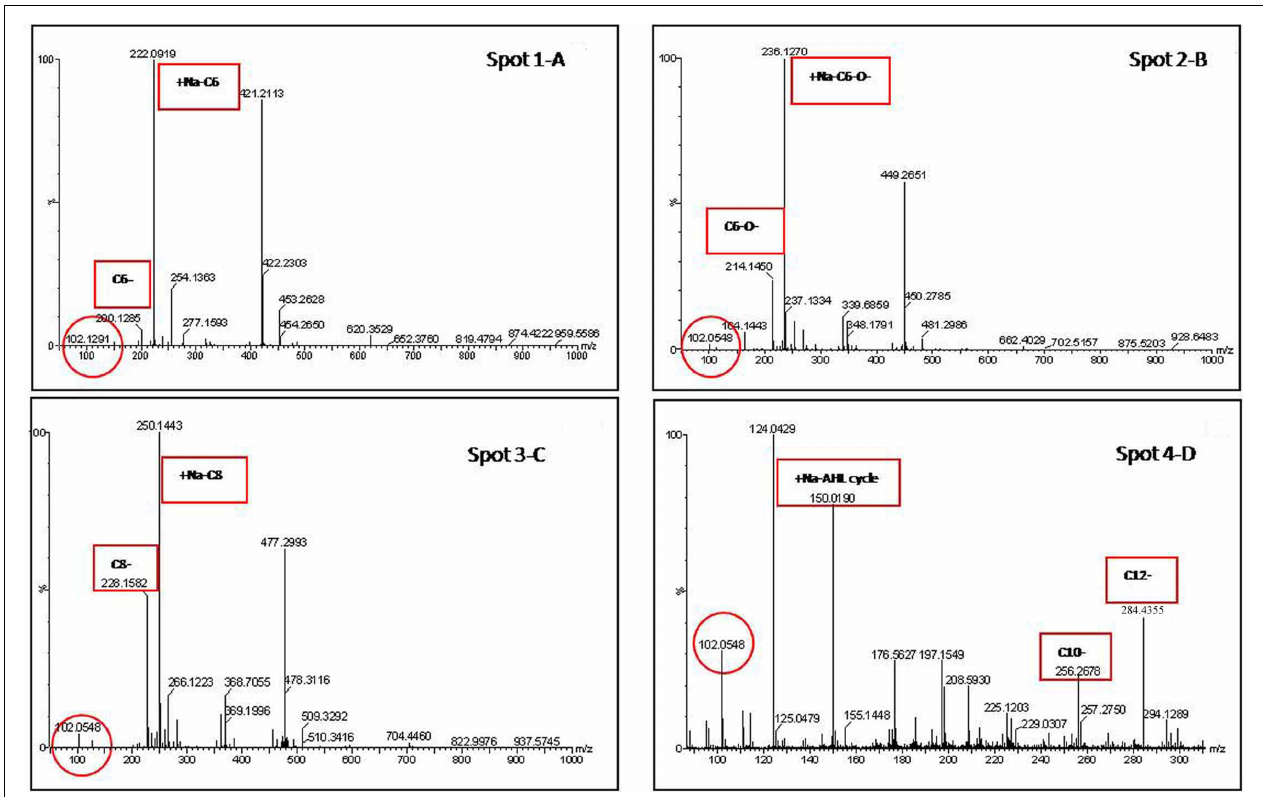
FIGURE 4 | Extracted ion chromatogram of the m/z 102 fragment (a characteristic of the homoserine lactone ring) of AHLs produced by representative strain (OTU2) recovered from preparative TLC. Identification of the AHL in the extract was determined from the mass spectrometry (MS) spectra by comparison with the corresponding AHL standards. For example, the MS data for the spot 1 (A) extract indicates the presence of a characteristic lactone fragment at m/z of 102 and the molecular ion peak at m/z of 200 or 220 [Na + ], suggesting the AHL to be C6-AHL. Accordingly, The spot 2 (B) , spot 3 (C) , and spot 4 (D) are C6-O-, C8-, and (C10- or C12-) AHL, respectively.